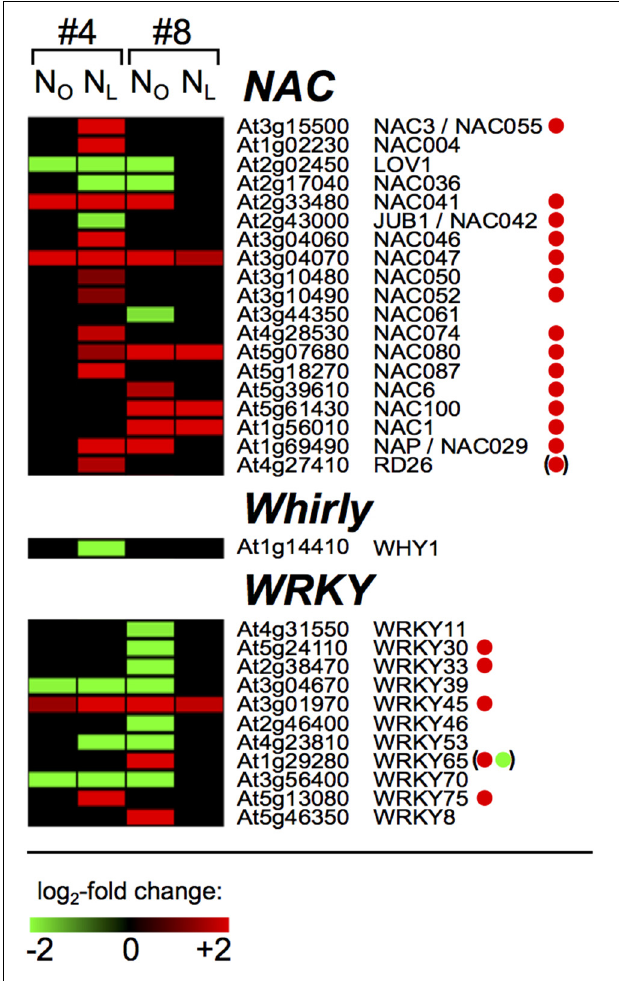
FIGURE 6 | Senescence associated oilseed rape NAC, Whirly and WRKY transcription factor genes. The heat maps display the upregulated (red bars) or downregulated (green bars) Brassica napus unigene homologs of Arabidopsis thaliana NAC, Whirly and WRKY family transcription factors in leaf #4 between 92 and 99 DAS and in leaf #8 between 92 and 106 DAS as indicated on top of the columns. Depicted are genes with expression ratios ≥ 3 and P adj < 0.05 ( n = 3). Green and red dots denote genes that were reported as leaf senescence-associated down- and upregulated in Arabidopsis thaliana by Breeze et al. (2011). Dots in parentheses indicate that this gene was not steadily regulated and WRKY65 was first up- and later downregulated in the course of leaf